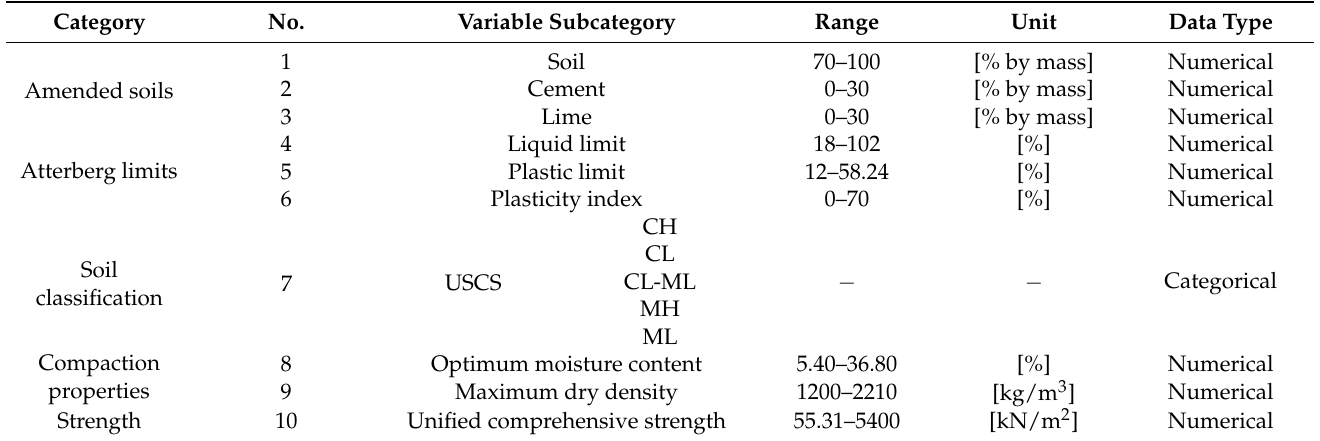
Table 1. Description of the features considered in the dataset.